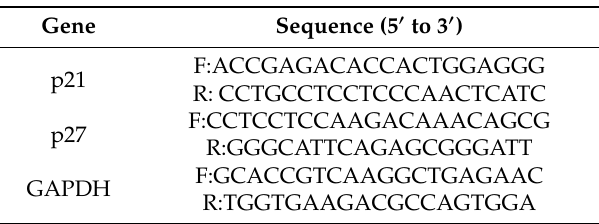
Table 1. Primer sequences of qPCR